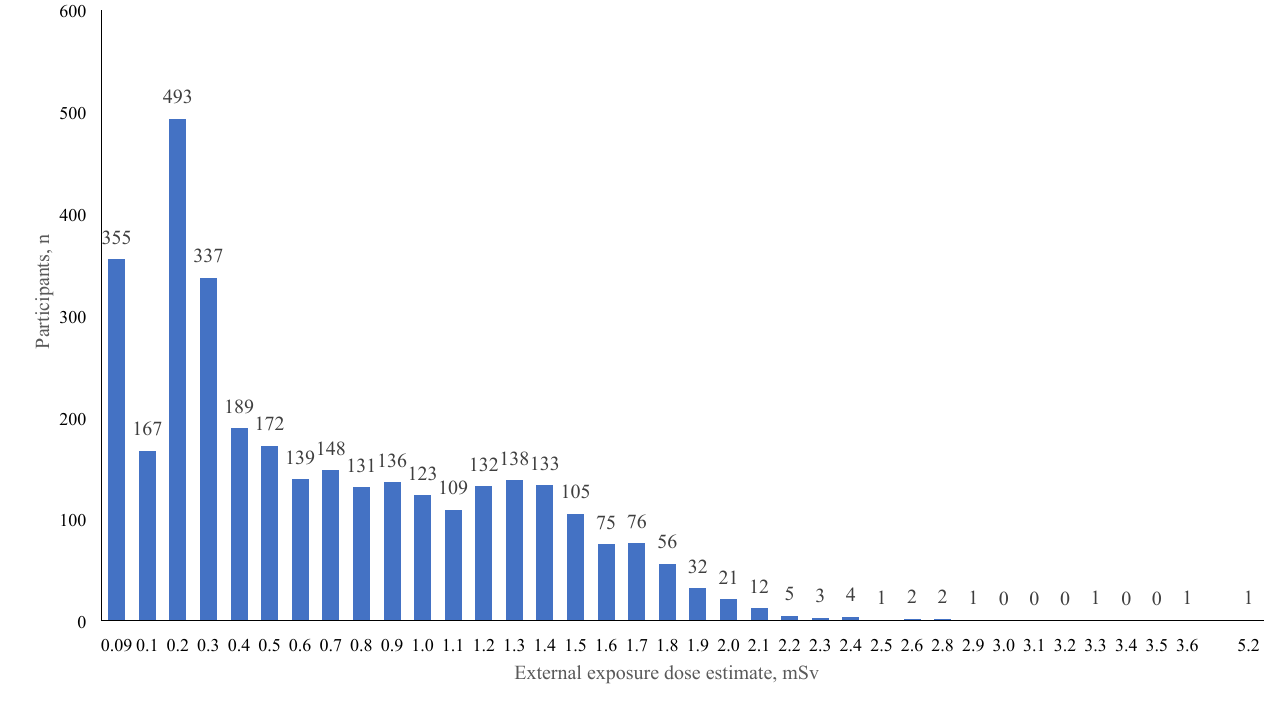
Figure 2. Distribution of external exposure dose estimates ( n = 3,300) Table 1. Characteristics of 6,875 cases according to external radiation